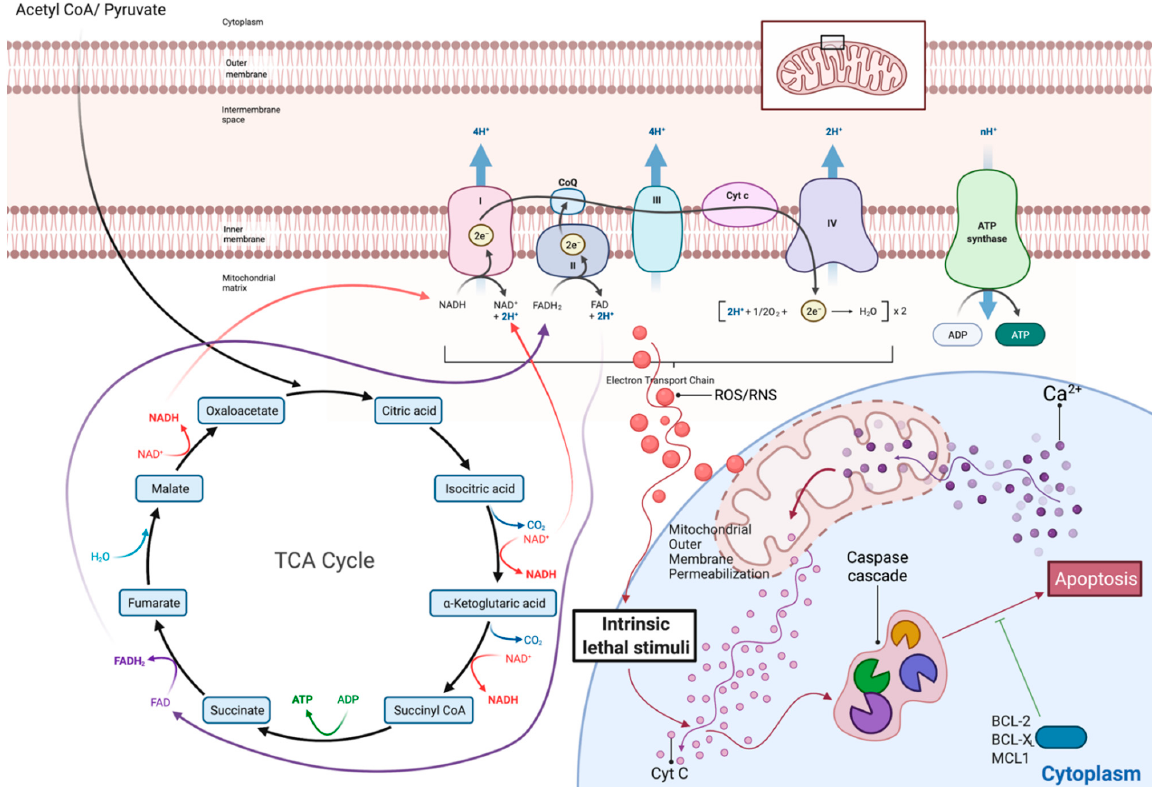
Figure 1. Overview of mitochondria tricarboxylic acid cycle (TCA) and electron transport chain (ETC). Coupling of TCA with the ETC is named oxidative phosphorylation (OxPhos) and is the main metabolic source of intracellular energy in the form of ATP. During the ETC, pooling of electrons (e − ) inside the ETC proteinic complexes, for instance due to imbalances between electron feeding and ETC capacity, leads to release of reactive oxygen species (ROS). To protect the cell from the effects of this oxidative stress, mitochondrial existence is coupled with an intrinsic ability of the organelle to induce cellular death, when its function is compromised. Ca +2 and/or other stimuli activate this intrinsic apoptotic pathway, which leads to increased mitochondrial outer membrane permeabilization. Release to the cytoplasm of the normal mitochondrial membrane-bound cytochrome c (Cyt c) activates a positive caspase regulatory cascade that leads to apoptosis. Pro-survival proteins belonging to the BCL-2 family (BCL-X, MCL-1, BCL-2) rescue cells from such events and are a major factor in both normal and malignant B cells’ physiology. Detailed analysis of the mechanisms of action of such antiapoptotic proteins is beyond the scope of this review and will therefore not be discussed further. Adapted from “Electron Transport Chain”, by BioRender.com (2020). Retrieved from https://app.biorender.com/biorender-templates (accessed on 6 July